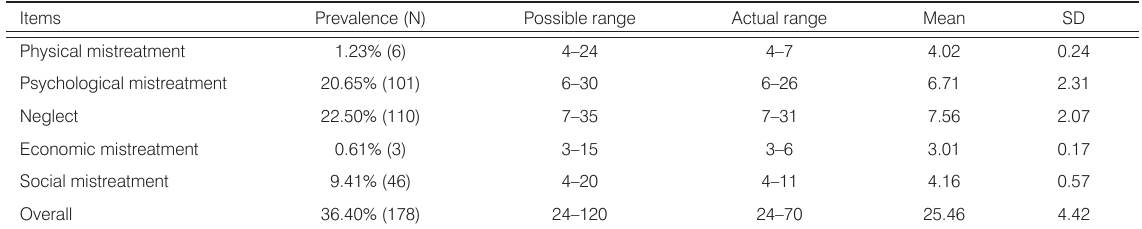
Table 2. Descriptive statistics of EM and its subscales (N = 489).